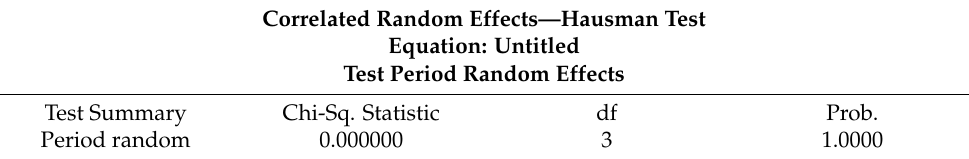
Table 15. Hausman Test.